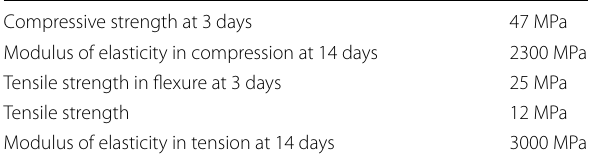
Table 1 Epoxy adhesive